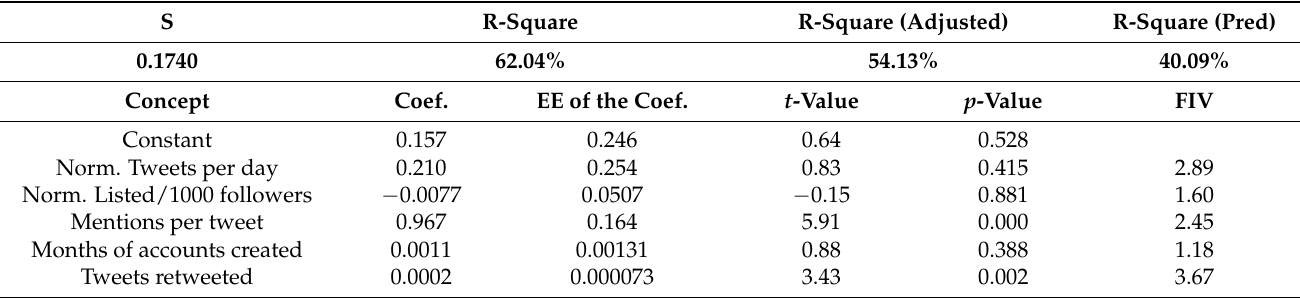
Table 5. First model